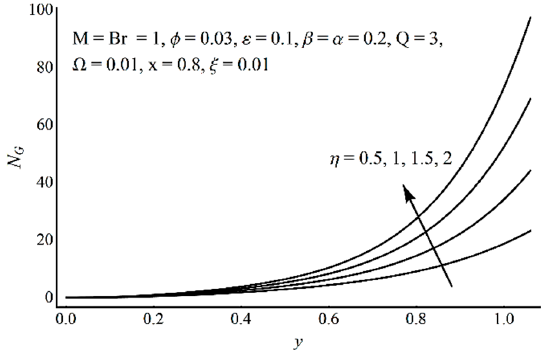
Figure 19. The total entropy generation number against various material parameter η values .